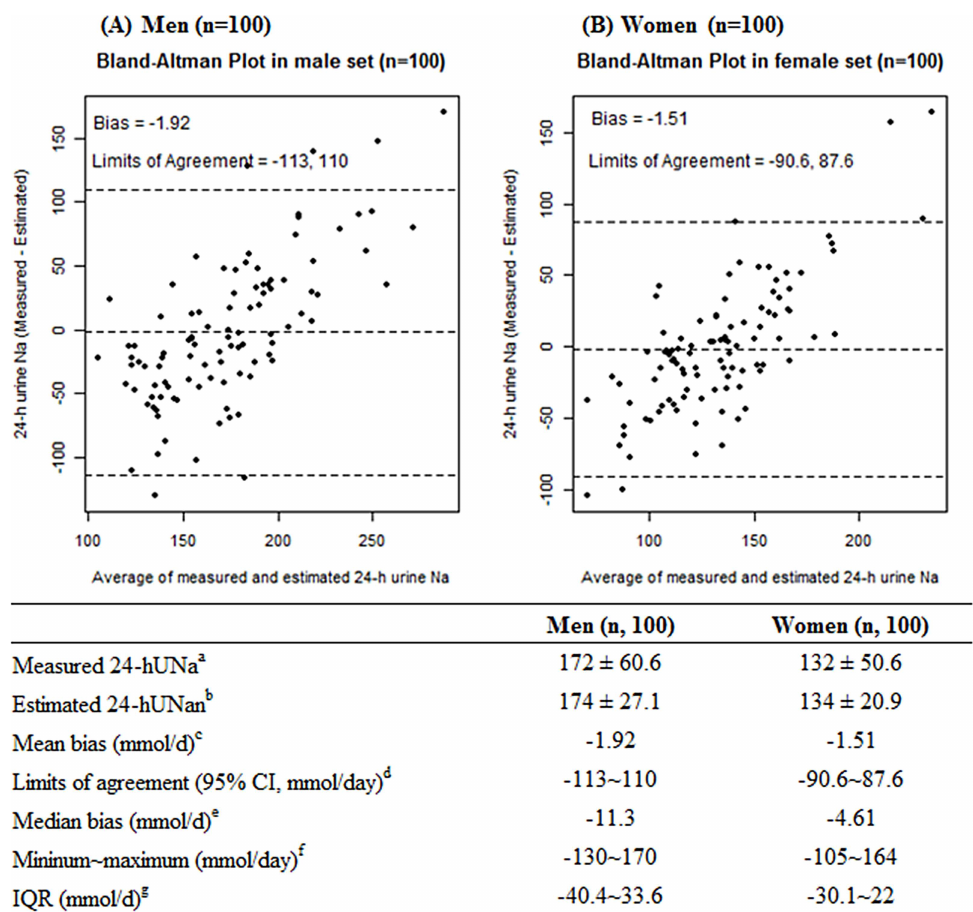
Fig 2. Bland-Altman plot of measured and estimated 24-hUNa by gender (validation set, study 2). The lines represent the mean bias (measured 24-hUNa—estimated 24-hUNa) and the 95% limits of agreement of the mean bias ± 1.96 × SD (the upper limit of agreement equals the mean bias ± 1.96 × SD of the difference; the lower limit equals the mean bias − 1.96 × SD) (panel A, men; panel B, women). 24-hUNa, 24-h urinary-sodium excretion. a Measured 24-hUNa using 24-h urine (mmol/d). b Estimated 24-hUNa using equation (mmol/d). c Mean bias (measured 24-hUNa—estimated 24-hUNa). d Limits of agreement (measured 24-hUNa—estimated 24-hUNa): 95% upper limit-95% lower limit. e Median bias (measured 24-hUNa—estimated 24-hUNa). f Range of difference (measured 24-hUNa—estimated 24-hUNa): minimum~maximum. g IQR (Interquartile range) of difference (measured 24-hUNa—estimated 24-hUNa).